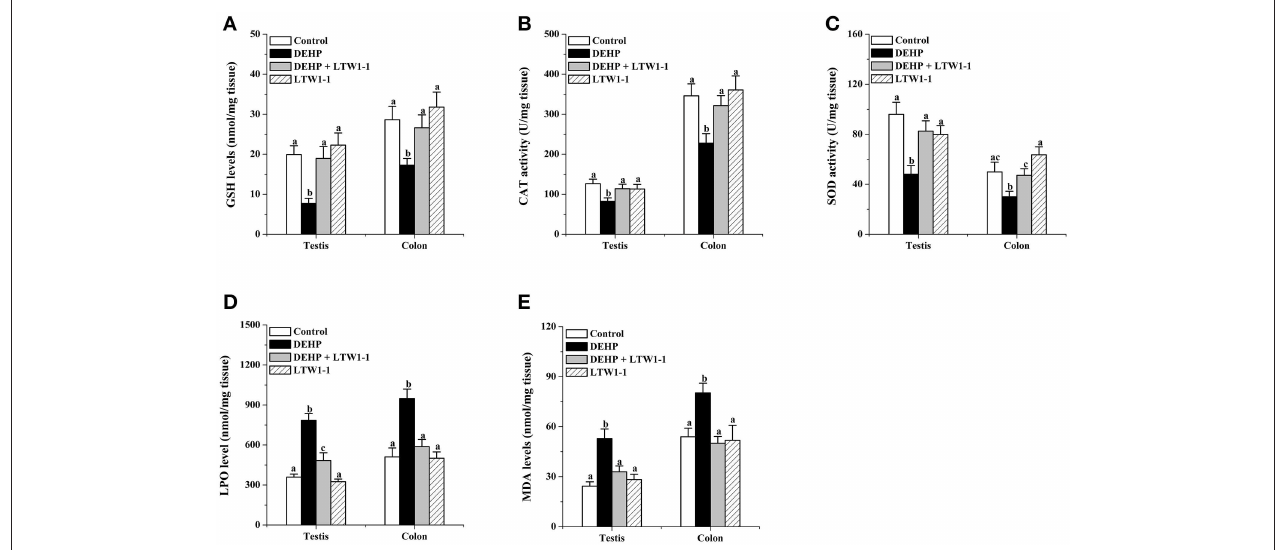
FIGURE 2 | Effects of L. plantarum TW1-1 treatment on GSH level, CAT, and SOD activity, and LPO and MDA concentrations in the testes and colon. (A) GSH concentration. (B) CAT activity. (C) SOD activity. (D) LPO concentration. (E) MDA concentration. The data are expressed as mean ± S.E.M. (n = 8), different letters represent significant differences between groups by Tukey’s test ( P < 0.05).